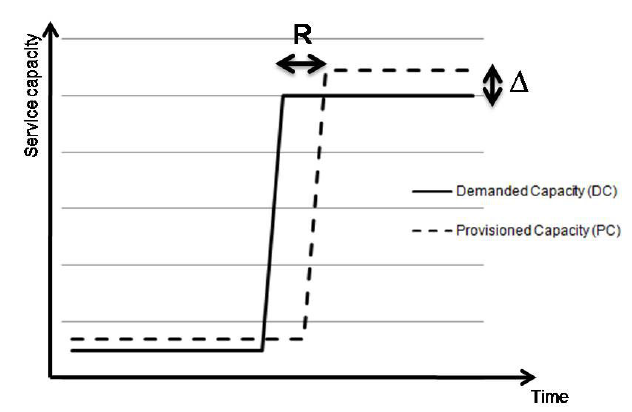
Figure 1: Inaccuracy ( ∆ ) and reconfiguration time ( R ) concepts